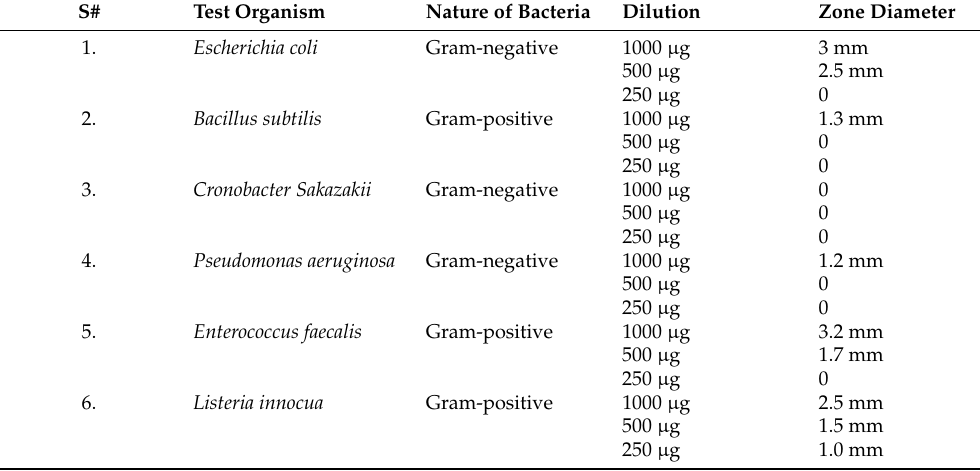
Table 2. Pathogens with in vitro antibacterial activity on nanoparticle dilutions.